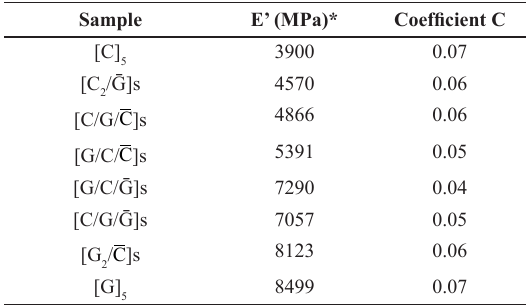
Table 2. E’ (at 30 °C) and Effectiveness Coefficient (C) values.